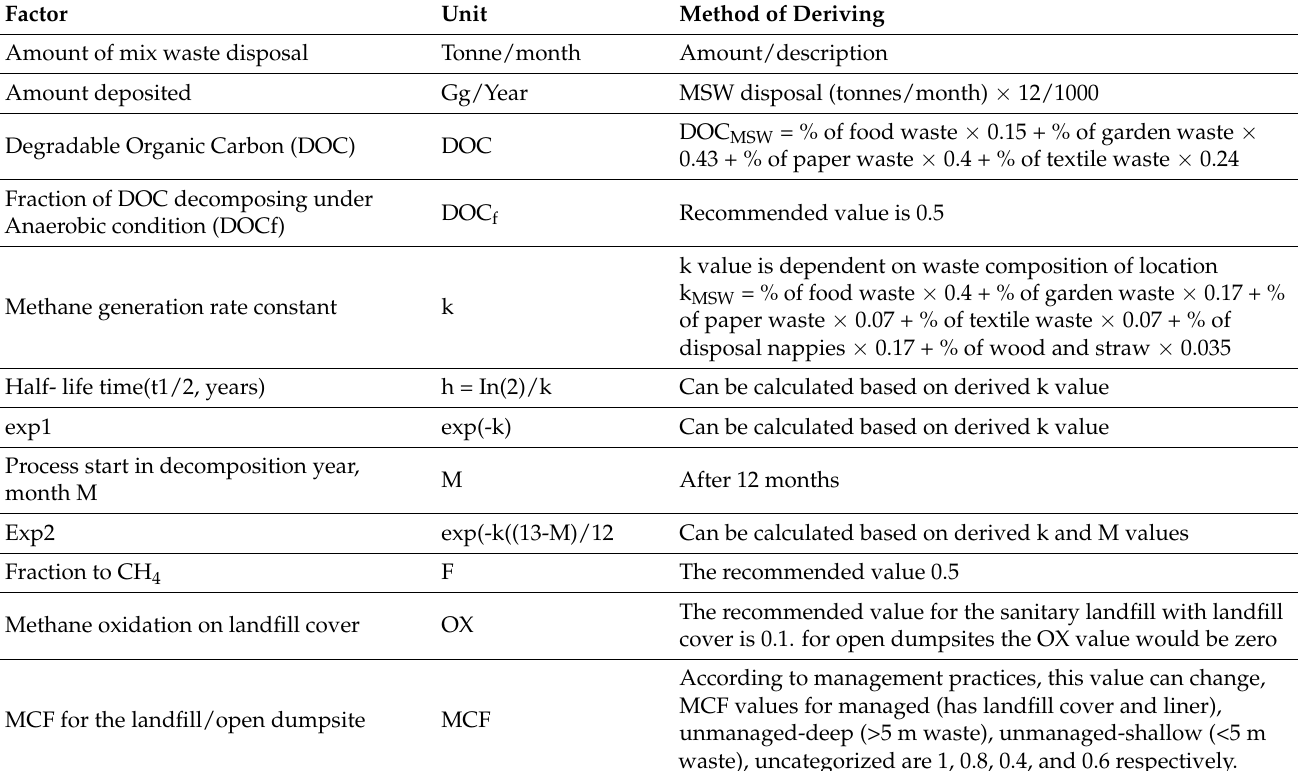
Table 2. Factors and default values used in the IPCC 2006 waste model [7]. The same values were used in the current